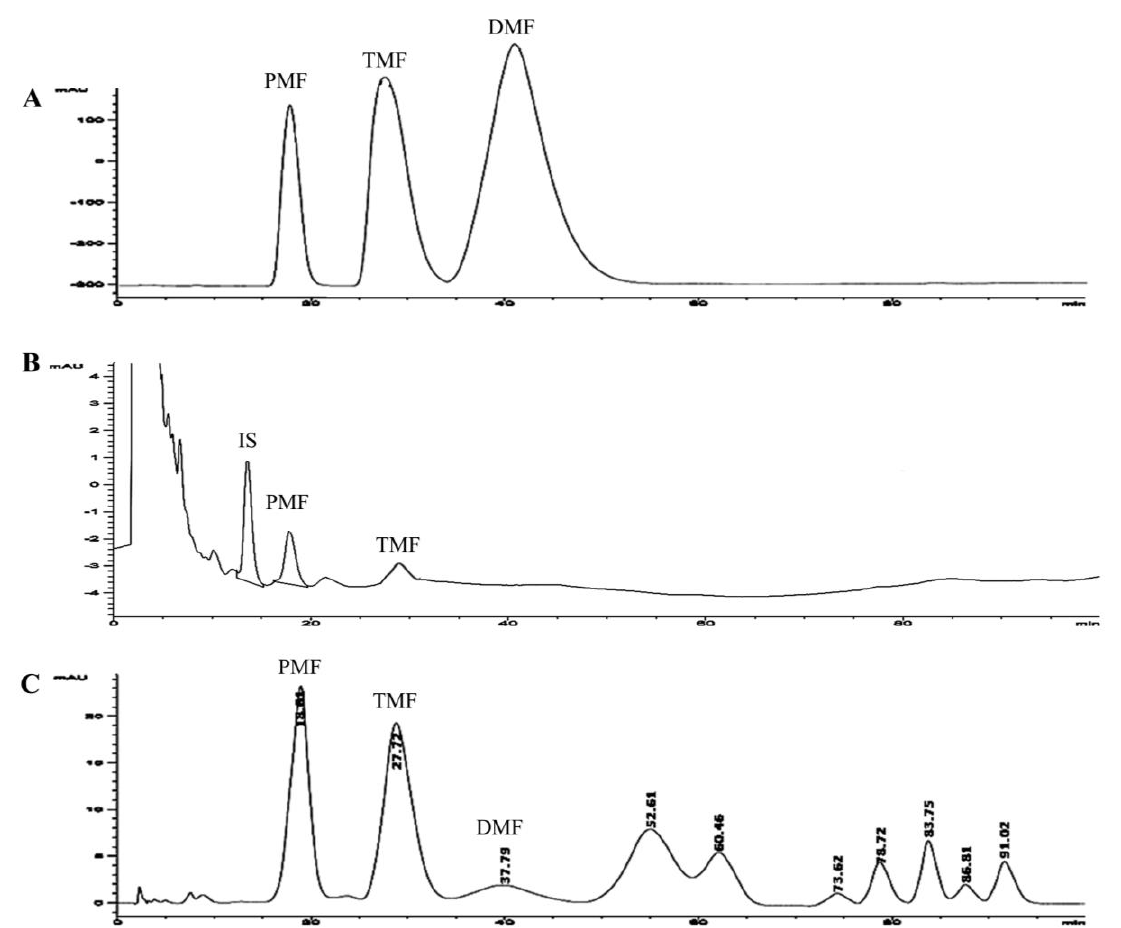
Figure 1. HPLC chromatograms of methoxyflavones; ( A ) = standard compounds; ( B ) = blood sample from a healthy subject following oral Kaempferia parviflora Wall. ex Baker (KP) extract 180 mg / day; and ( C ) = KP capsule. PMF: 3,5,7,3 (cid:48) ,4 (cid:48) -pentamethoxyflavone, TMF: 5,7,4 (cid:48) -trimethoxyflavone, DMF: 5,7-dimethoxyflavone, IS: internal standard. Table 1. Composition of test products.